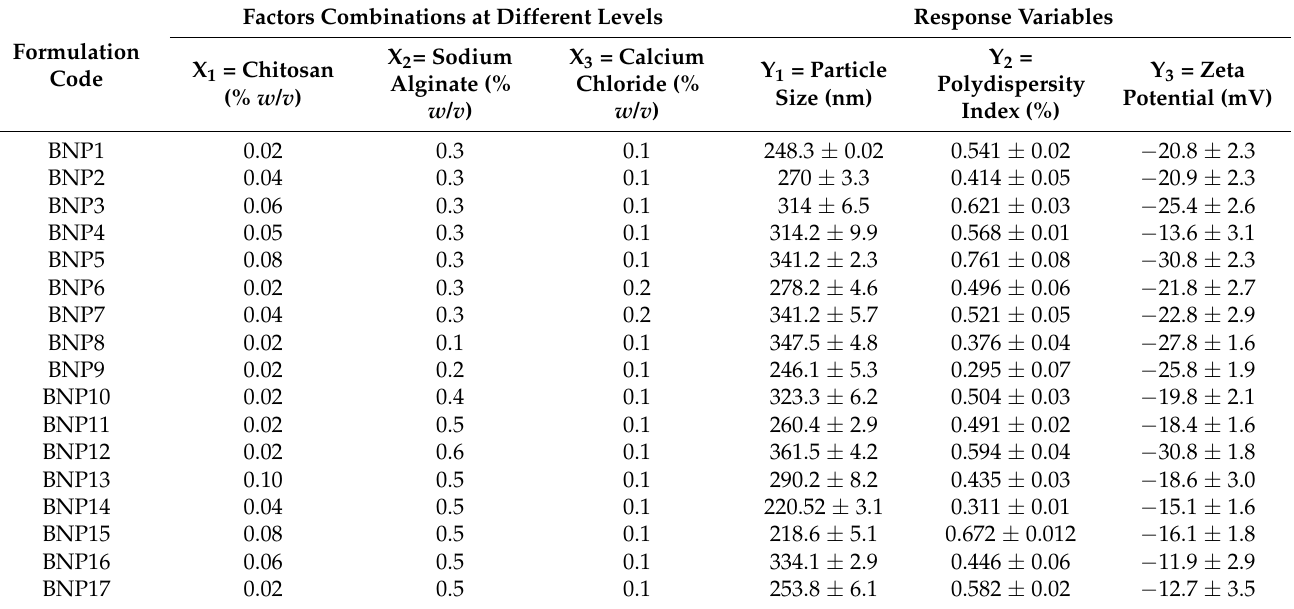
Table 1. Variables and observed responses in